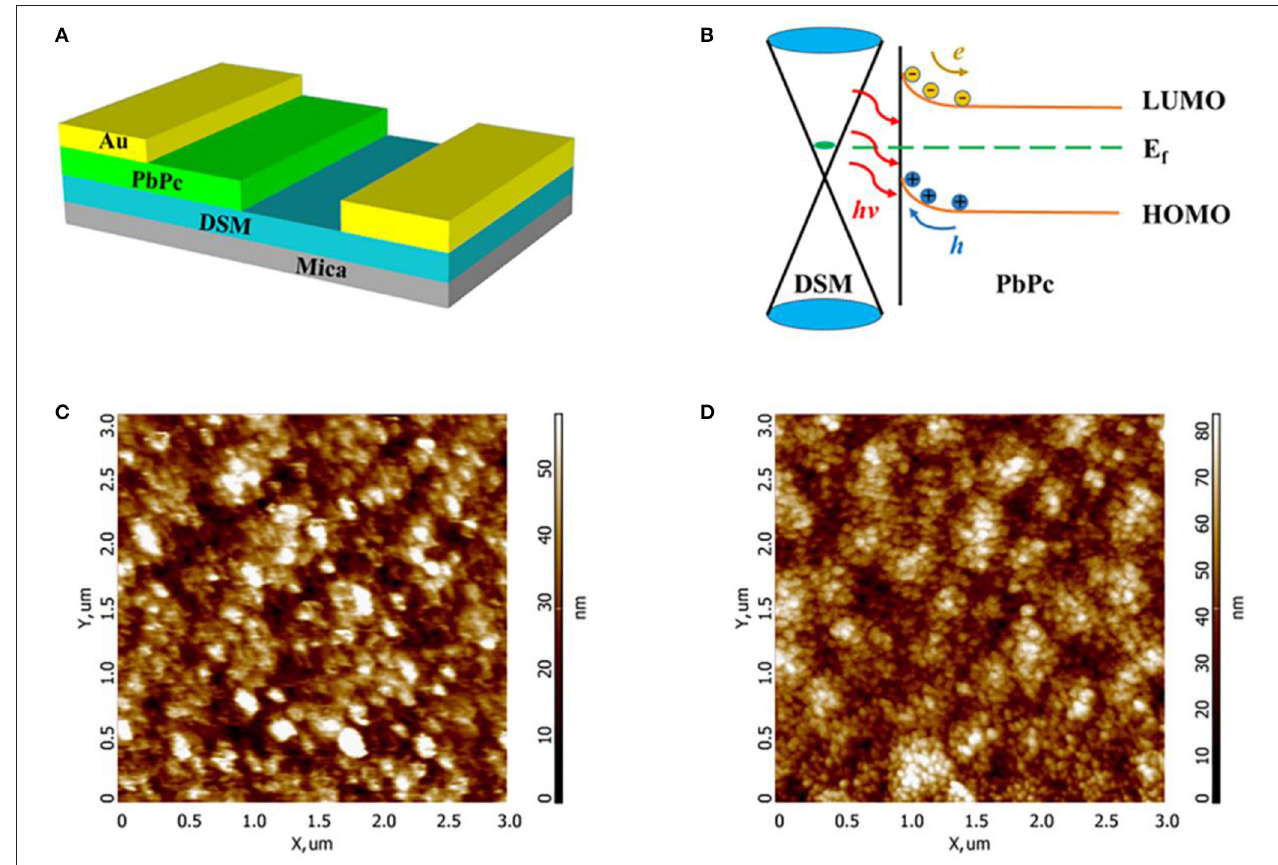
FIGURE 1 | Structure and morphology of the devices. (A,B) Device schematic diagram and energy-band diagram of DSM/PbPc thin film heterojunction photodetector, respectively. (C,D) AFM surface diagram of PbPc thin film on Cd 3 As 2 and (Cd 1